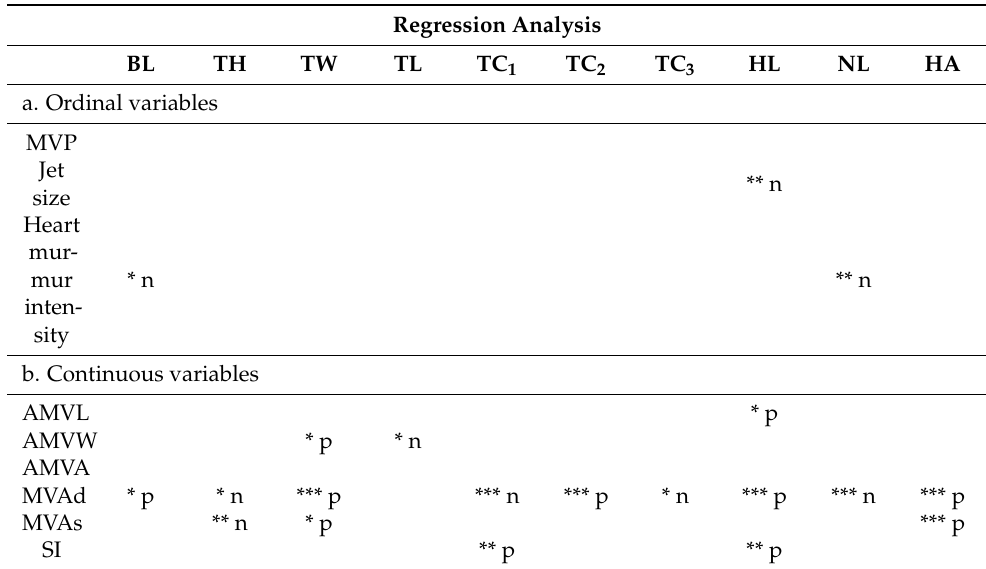
Table 3. Results of the regression analysis applied to determine the influence of morphometric variables on the clinical and echocardiographic parameters of all included